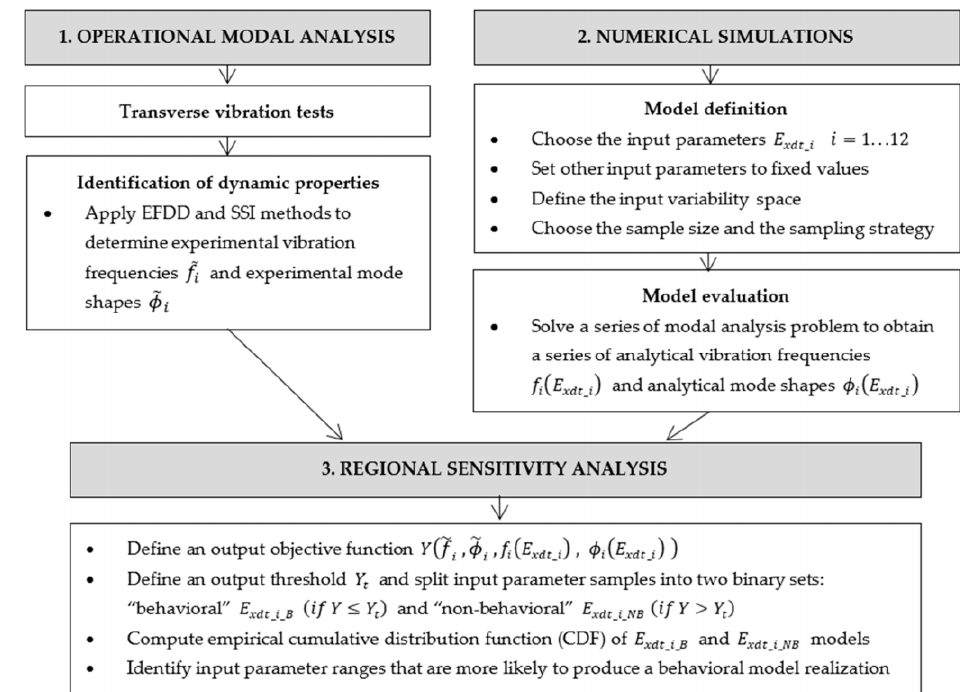
Figure 5. Logical diagram of E xdt local variability